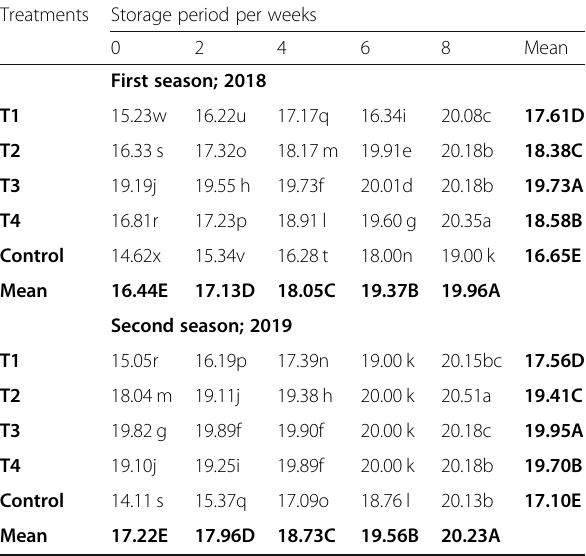
Table 5 Effect of preharvest spraying with moringa leaf extract, boric acid, and chelated calcium on SSC:TA ratio in fruit juice of Hollywood plum stored at 0 ± 1 °C and RH 85 – 90% during 2018 and 2019 seasons